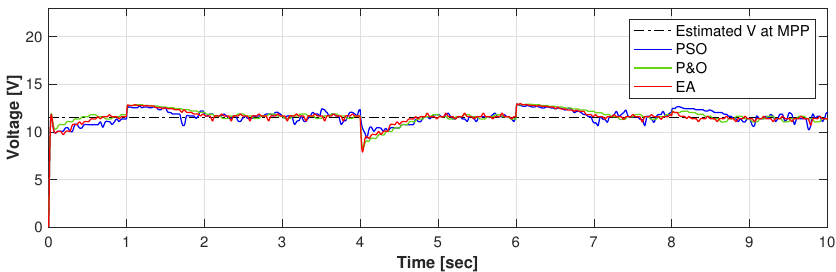
Figure 17. Voltage from the PV source ( V pv ) through time from low power simulations.